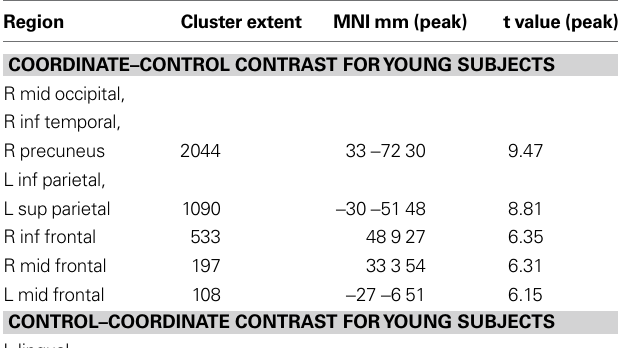
Table 3 | Top clusters from group statistical maps, age